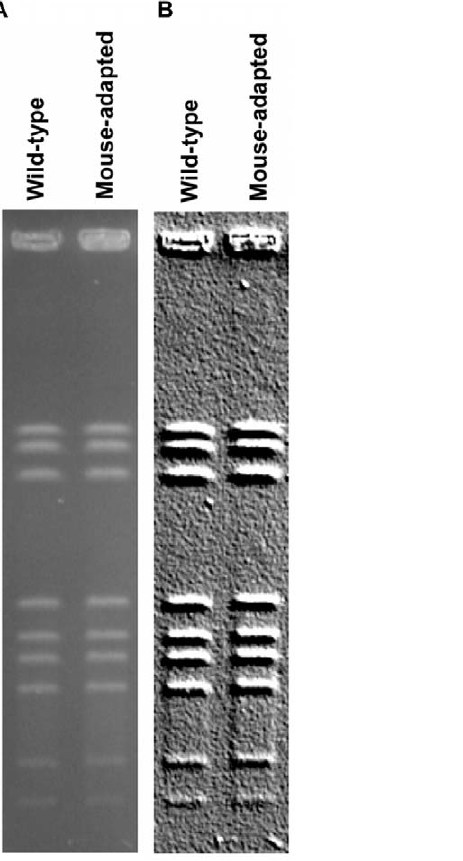
Figure 2. Absence of large genomic changes during passage. (A) Pulse field gel electrophoresis image to compare wild-type and mouse-adapted bacteria. (B) The same gel with an image filter as an attempt to detect rare bands.